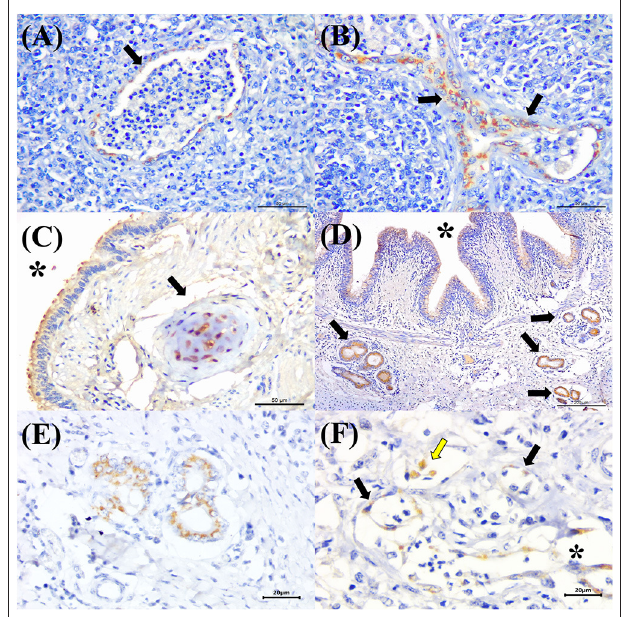
FIGURE 4 | Immunohistochemical detection of BVDV antigens in cattle with bovine respiratory disease. There is positive immunoreactivity (arrows) to BVDV in the epithelial cells of the (A) terminal and (B) respiratory bronchiole of a cow with bronchopneumonia. (C) Observe positive immunolabeling at chondrocytes of the hyaline cartilage (asterisk), epithelial cells of the bronchus (arrow), (D) mixed peribronchial glands (arrows), and bronchial epithelial cells (asterisk); (E) closer view showing positive immunoreactivity within epithelial cells of the mixed peribronchial glands. (F) BVDV antigens within alveolar macrophages (yellow arrow), the endothelia of a capillary (black arrows), and venule (asterisk) of the lung. Immunoperoxidase counterstained with hematoxylin. Bar: (A–C) 50 µ m; (D) 200 µ m; (E,F) 20 µ